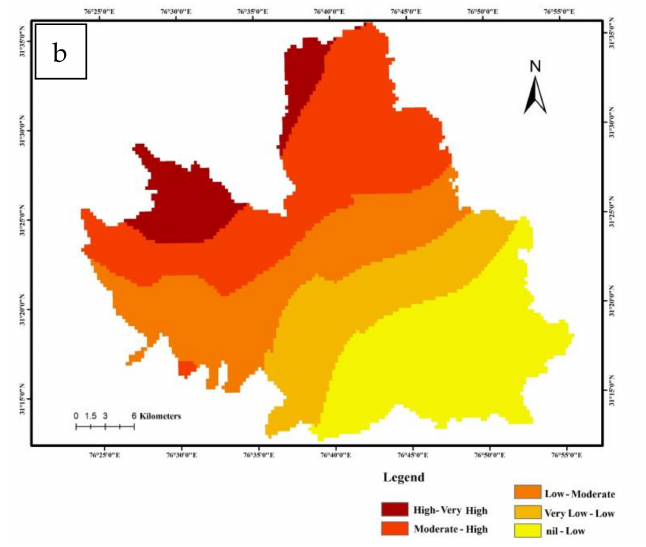
Figure 11. ( a ) Rainfall map of Bilaspur district; ( b ) Rainfall index map of Bilaspur district.